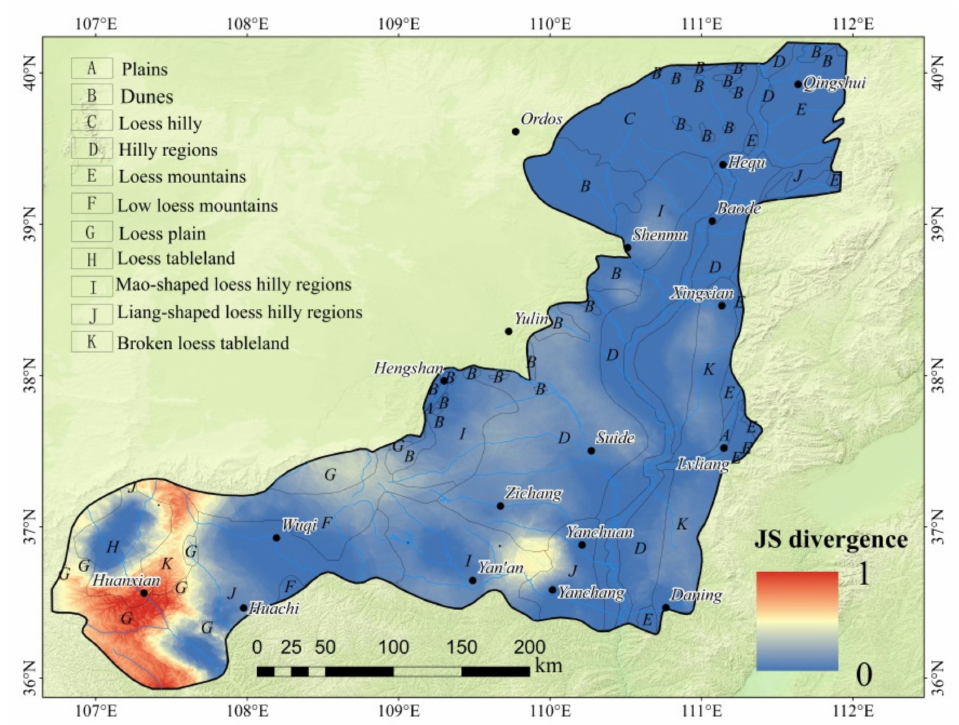
Figure 10. The map of JS divergence after being overlaid on the geomorphic map (the geomorphic map was obtained from the Atlas of Soil and Water Conservation in the Loess Valley).